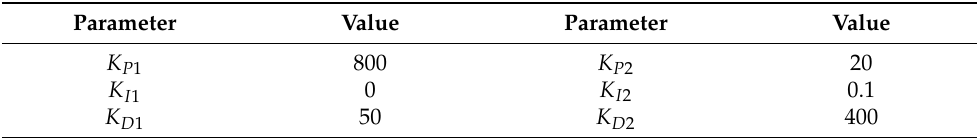
Table 3. Parameters of